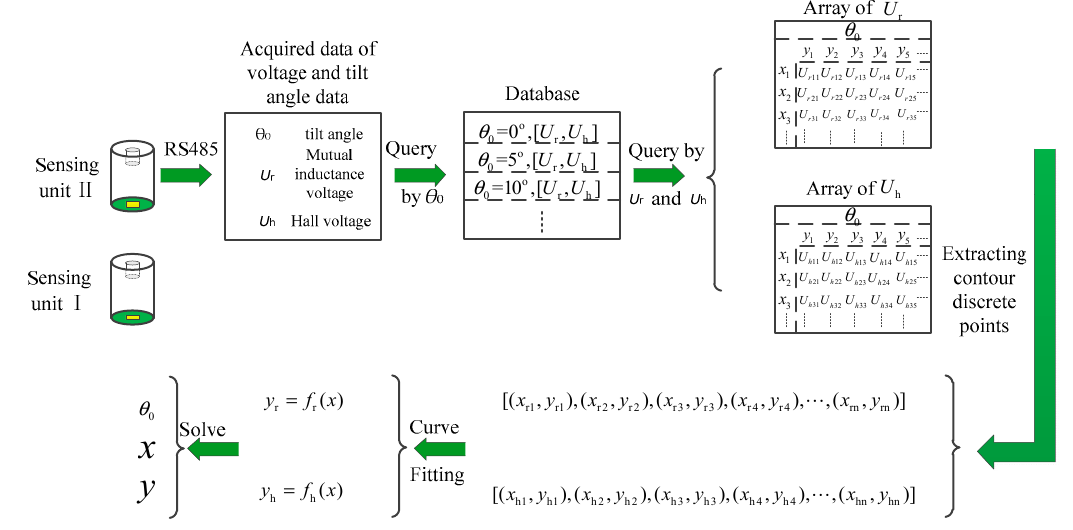
Figure 15. Flow chart for displacement solution.